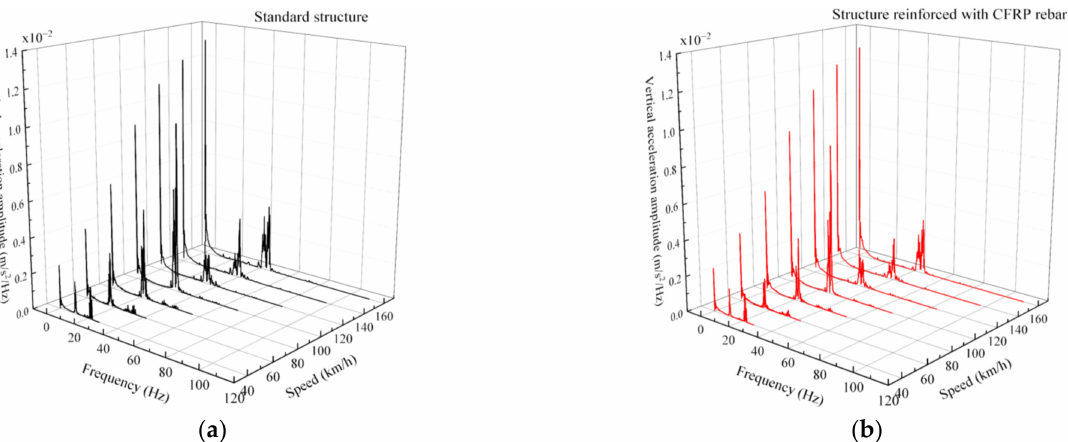
Figure 19. Spectrum of the vibration amplitude at point A. ( a ) Acceleration amplitude-frequency for the standard structure; ( b ) acceleration amplitude-frequency for the structure reinforced with CFRP